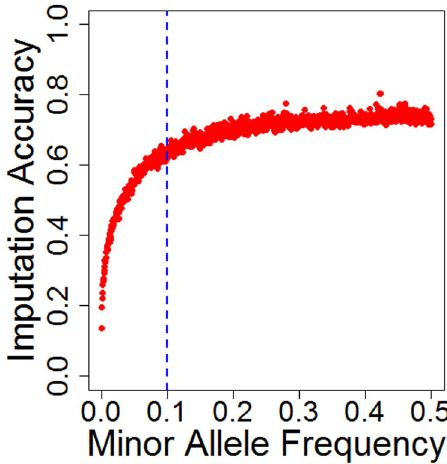
Fig. 2 Imputation accuracy against minor allele frequency (MAF). SNPs were divided into bins of SNPs with common